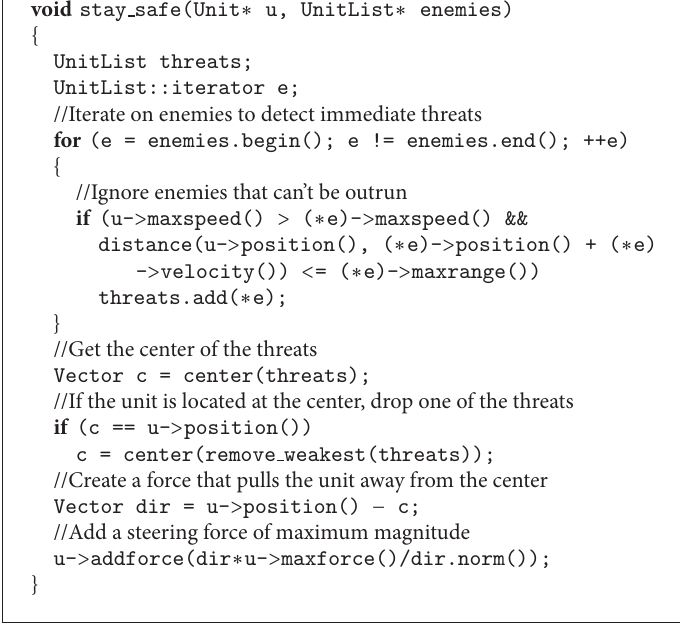
Algorithm 6: Avoiding enemy attacks by staying out of range. This function can be used for kiting.